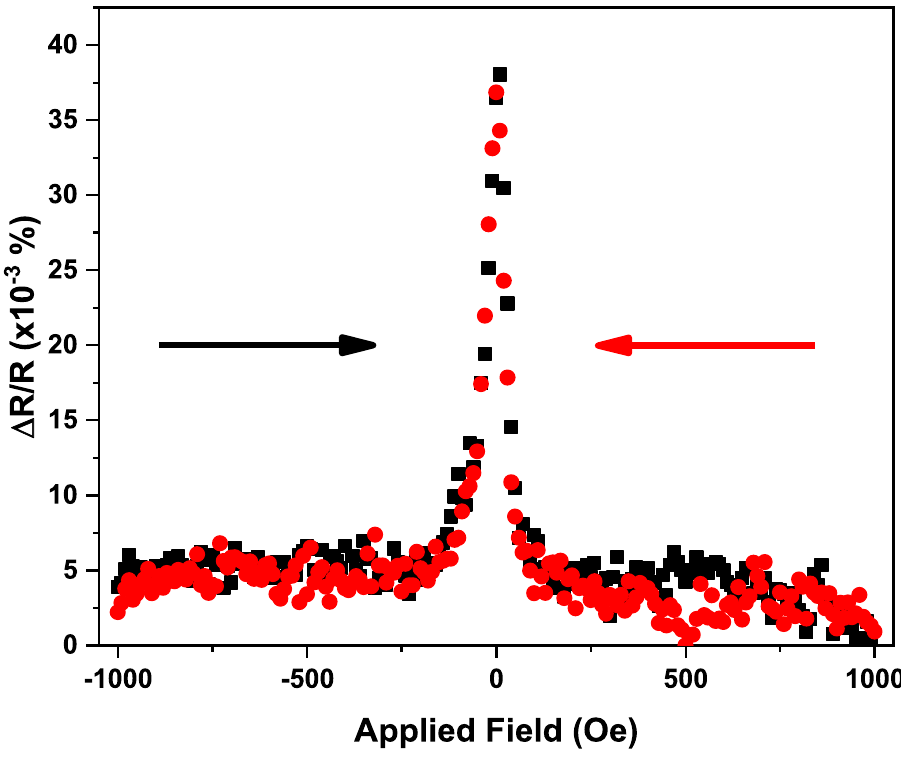
Figure 1. Magnetic properties of a CFAS/Ag/CFAS GMR device with the diameter of 150 nm × 100 nm. GMR curves measured under an applied field of ± 1 kOe and a sensing current of 50 µA before the current crystallisation by an applied current of 500 µA for 1